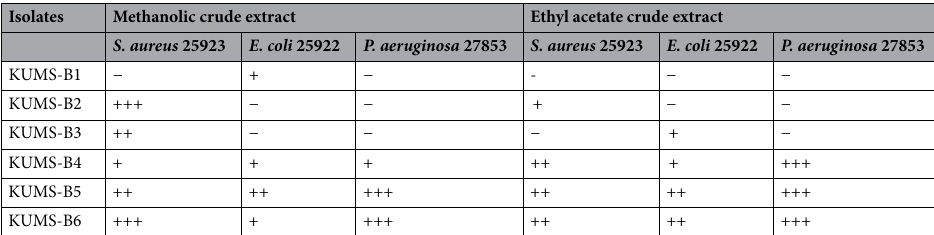
Table 2. Antibacterial effects of Endophytic actinobacteria isolated from Luffa cylindrica against tested bacteria. Imipenem and vancomycin were used as positive controls, while methanol and ethyl acetate were negative controls. +++, strong activity; ++, medium activity; + weak activity and − no activity as compared to the positive controls.